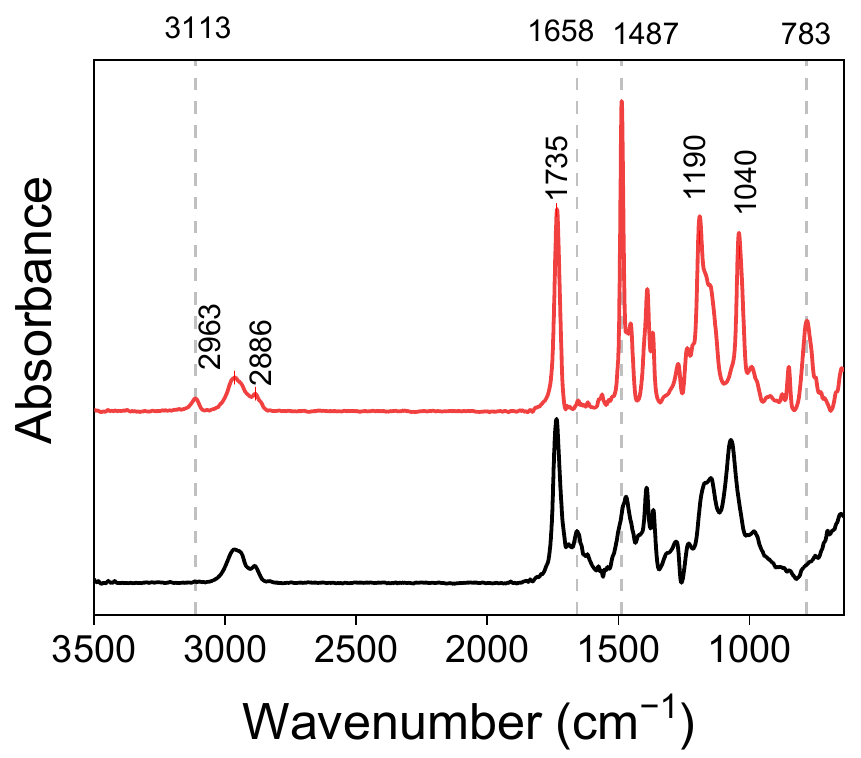
Figure 4. FT-IR spectra of ProDOT-Poly(MM) (red) and Poly(ProDOT)-Poly(MM) (black) brushes. Table 2. Atomic concentration determined by XPS for ProDOT-Poly(MM) and Poly(ProDOT)- Poly(MM) brushes grafted from quartz.